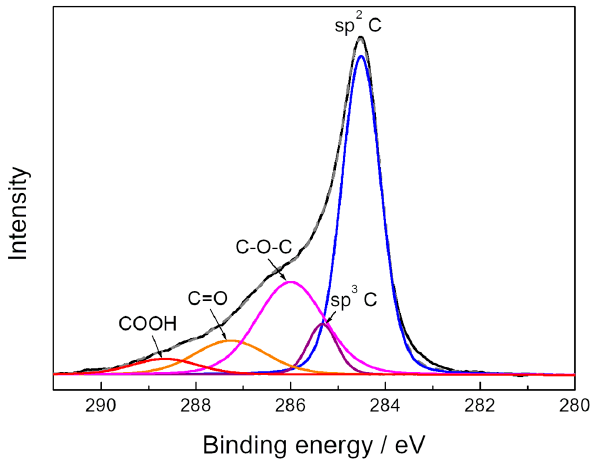
Table 1. Elemental composition of the GPS surface. C, at.%